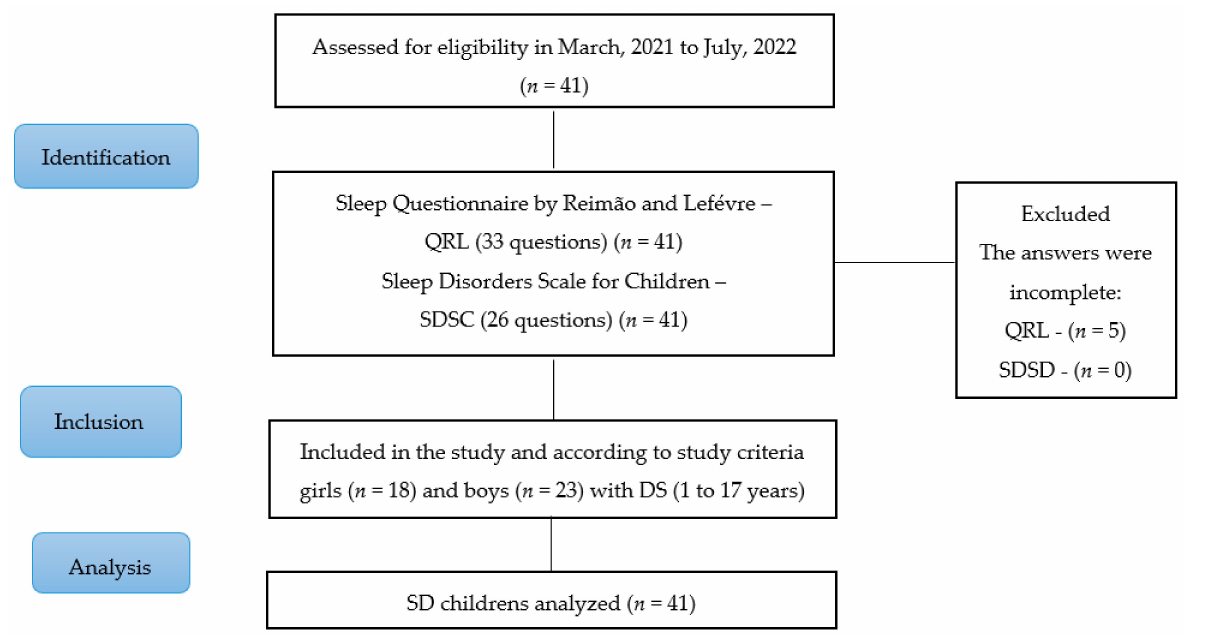
Figure 1. Flowchart of the study.